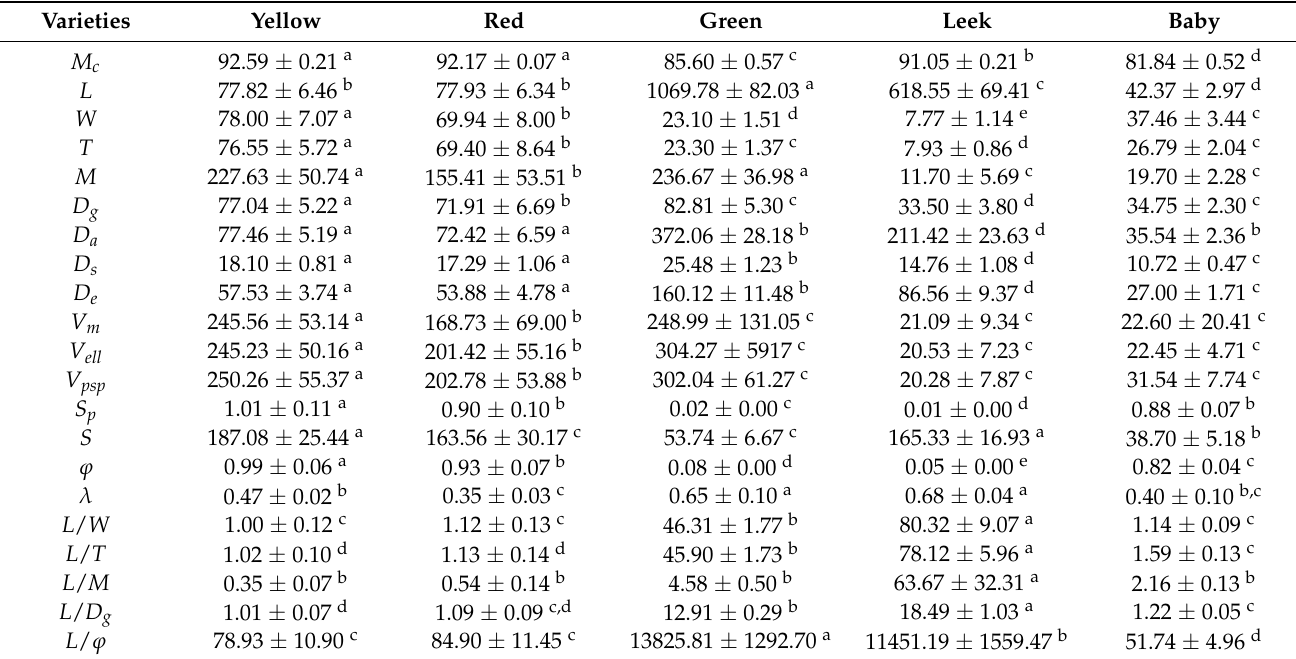
Table 1. Some structural parameters of onion bulbs.